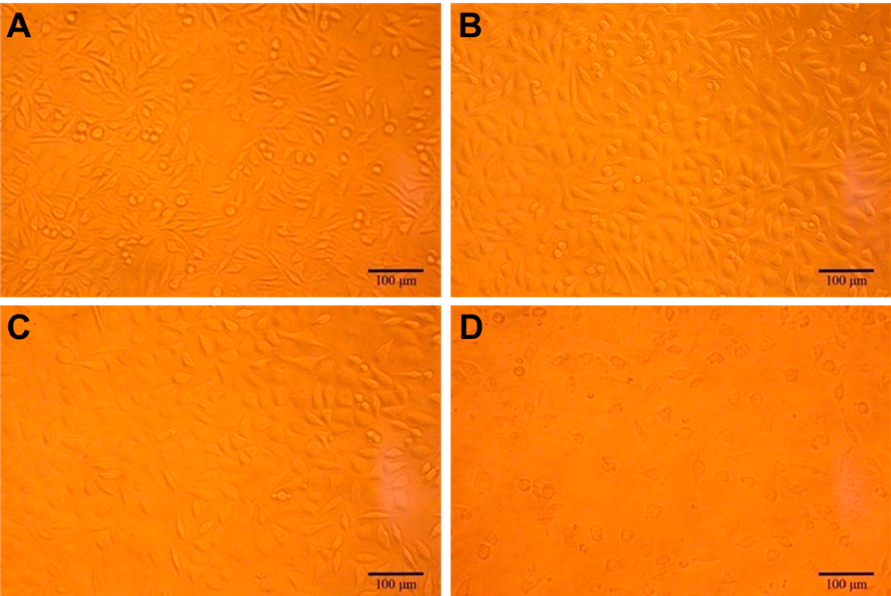
Figure 7. An optical micrograph of L929 cells cultured for 72 h, at different concentrations of 3D printed PLGA scaffold extract. ( A ) Negative control, ( B ) 50 mg/mL, and ( C ) 100 mg/mL of the PLGA scaffolds as the treatment group, and ( D ) Positive control (Phenol).